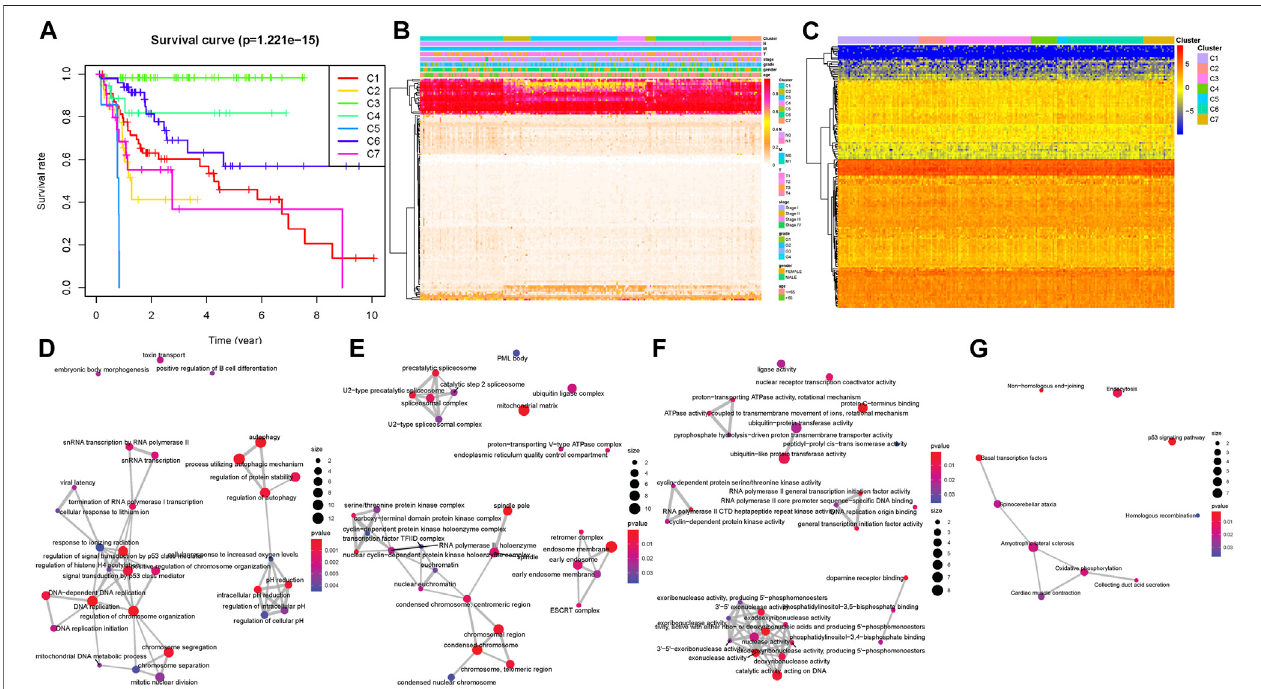
FIGURE 1 | Inter-cluster prognosis and clinical signi fi cance analysis. (A) Survival curves of different tumor subtypes. The number of samples in each cluster is shown in parentheses in the legend. The log-rank test was used to assess the statistical signi fi cance of differences between subtypes. (B) Heatmap of the DNA methylation levels in the seven clusters and their clinical characteristics. The color from red to white shows a trend from high expression to low expression. (C) Cluster analysisheatmap forannotated genesassociatedwiththe 184CpG sites. Crosstalk analysisofprognostic DNAmethylationgenesintheenriched KEGG pathway gene ontology (D – F) and KEGG (G)